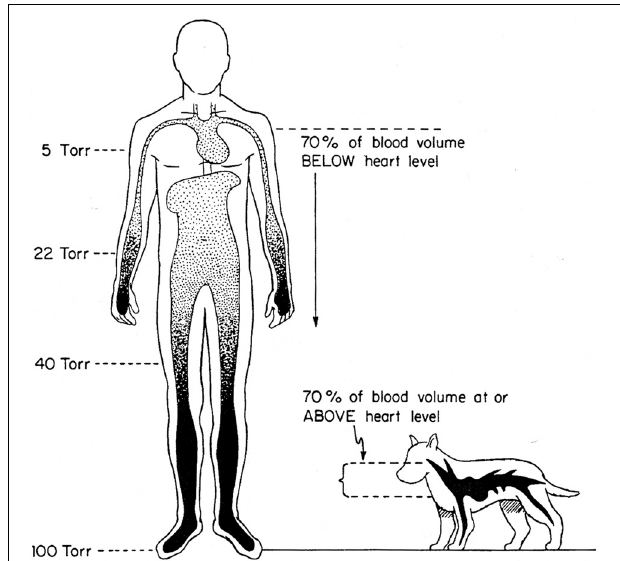
FIGURE 3 | Effects of terrestrial gravity on the cardiovascular system: the upright position. The impact of microgravity affects 70 and 30% of blood volume in humans and dogs, respectively. From Rowell